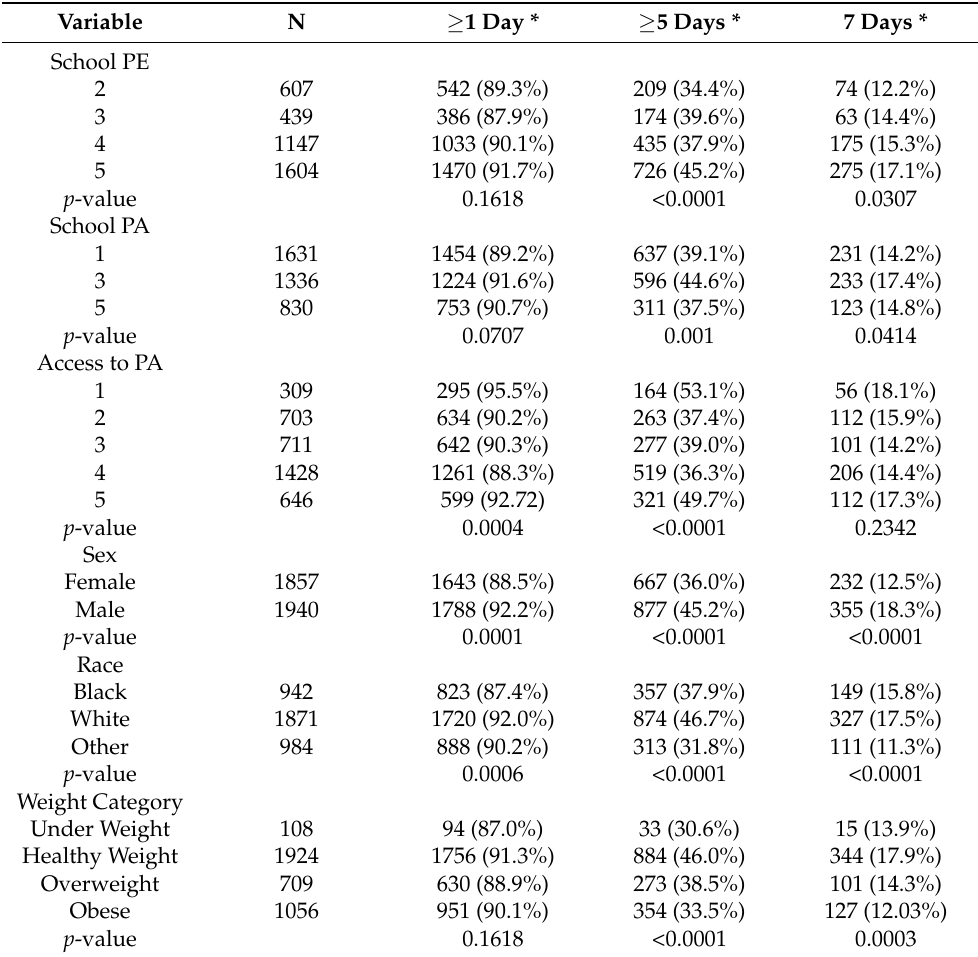
Table 3. Count (percent) of participants reporting 60 min of self-reported PA on at least one, five or seven day(s) per week) by schools’ PE and PA opportunities, sex, ethnicity, and weight